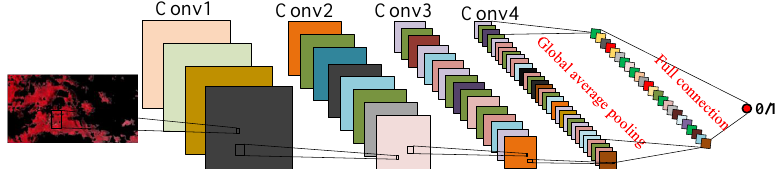
Figure 8. Structure of the proposed discriminator